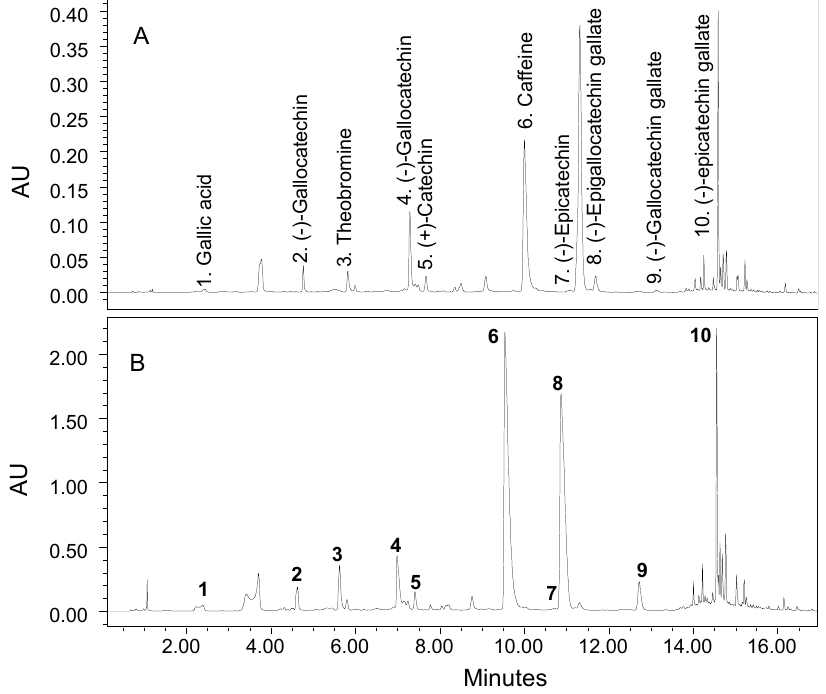
Figure 4. Typical UPLC chromatograms of catechin compounds in green tea leaves ( A ) and flakes ( B ). Table 4. Composition of catechin compounds in purple tea leaves and